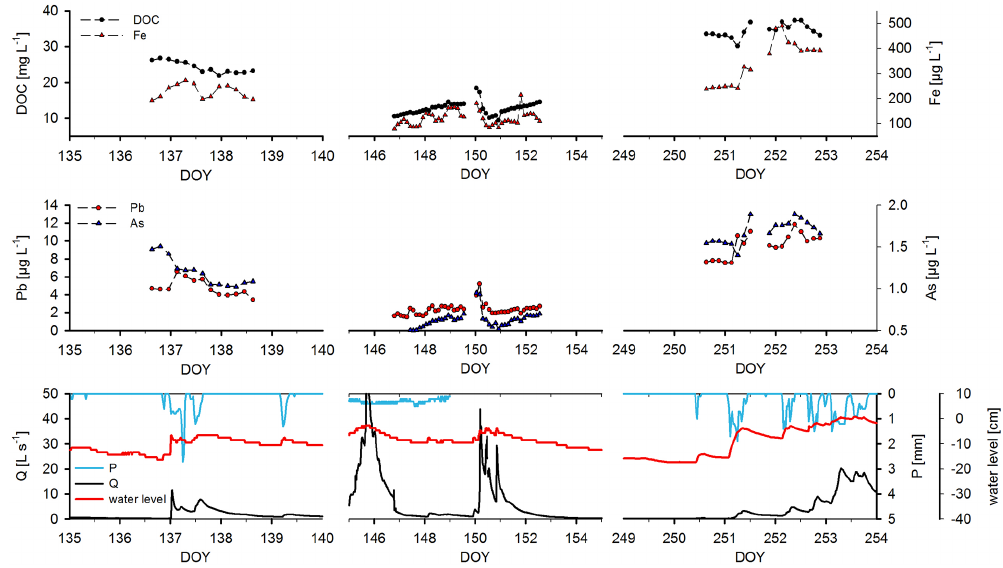
Figure 3. High-resolution DOC, As and Pb concentrations during recorded spring (DOY 135–155) and fall (DOY 250–260) events. Records of bog water level, precipitation (30min resolution) and discharge